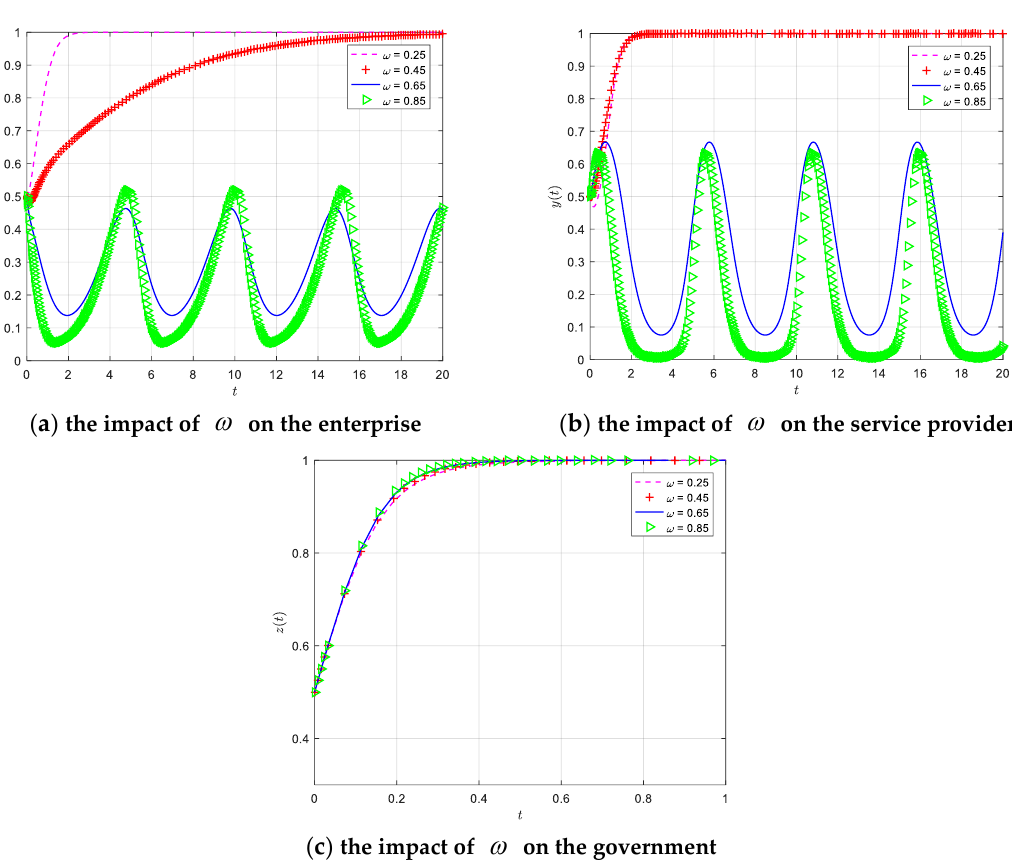
Figure 8. The impact of different system maintenance cost coefficients ω on the enterprise, service provider, and government.